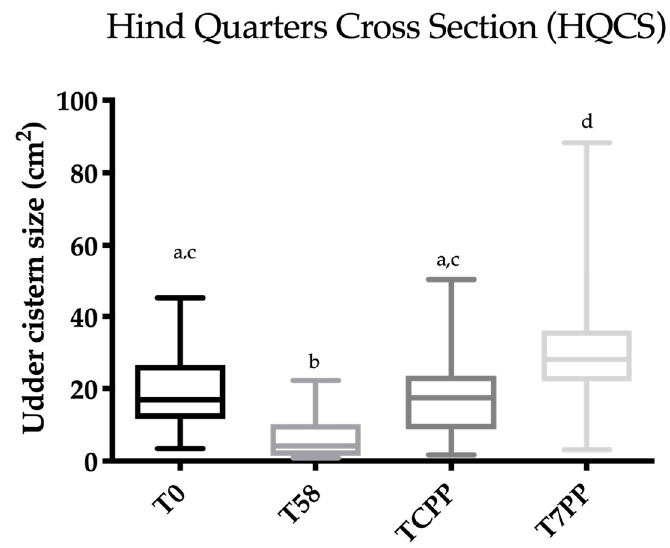
Figure 6. Scatter box plot showing the median, minimum and maximum values of the ultrasonographic udder cistern size between T0 vs. T58 vs. T colostrum production phase (TCPP) vs. T 7 days post-partum (T7PP) for the hind quarter longitudinal section (HQLS). Legend: a ≠ b ≠ c ≠ d: p < 0.05.